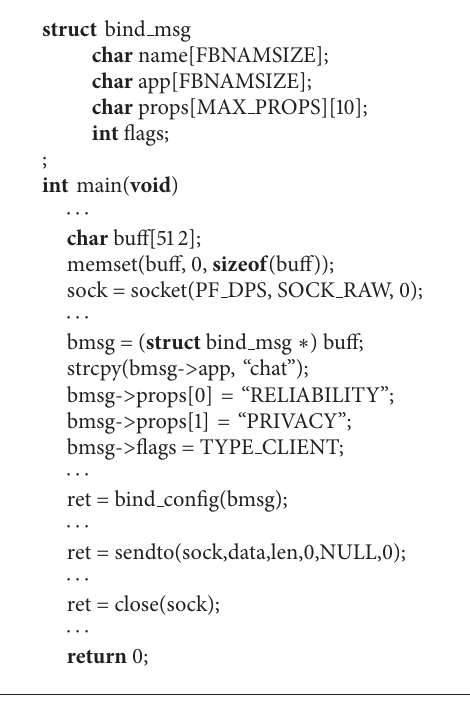
Algorithm 1: Dynamic protocol stack architecture API